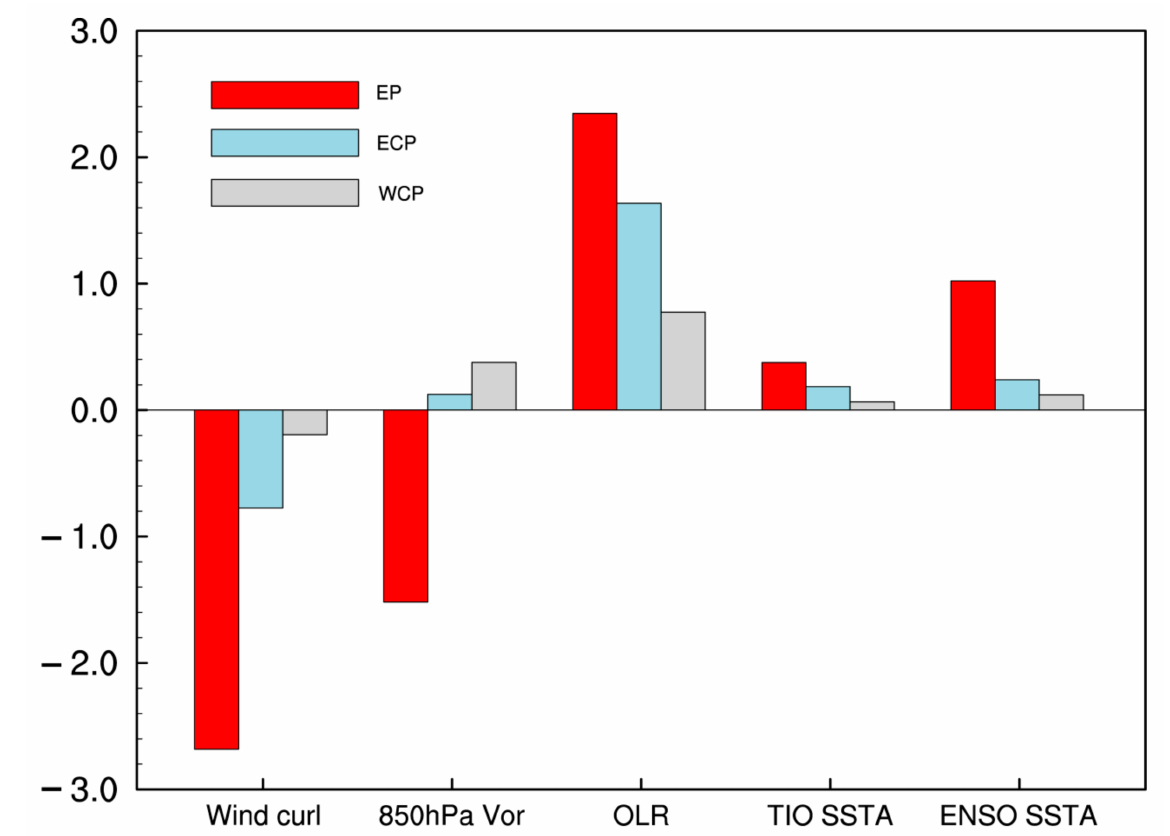
Figure 8. Regional mean wind stress curl (10 − 8 N · m − 3 ), 850 hPa vorticity (10 − 6 S − 1 ) and OLR (10 1 W · m − 2 ) over SCS, SSTA over the Indian Ocean ( ◦ C) and ENSO SSTA ( ◦ C) or EP El Niño (red), ECP El Niño (blue) and WCP El Niño (gray) during spring (MAM). The ENSO SSTA is defined as the mean SSTA over the Niño3.4 region for EP El Niño and Niño4 region for ECP and WCP El